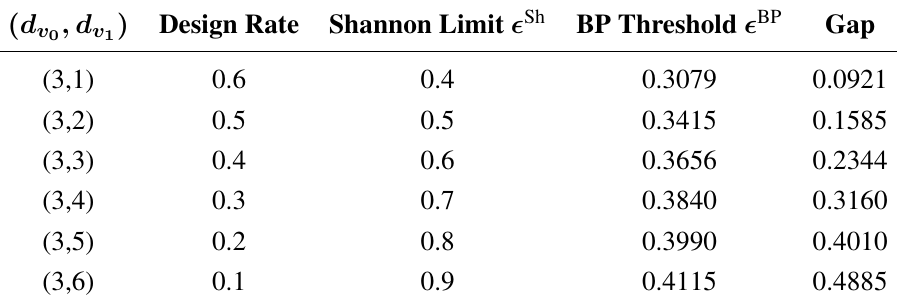
Table 2. BP thresholds of LDPC block codes over BECs.